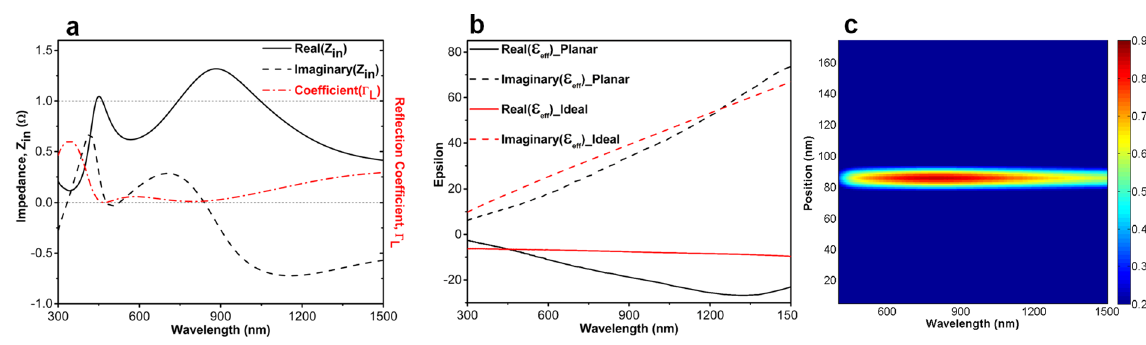
Figure 3. The extracted values for ( a ) input impedance and reflection coefficient of the MIMI structure, ( b ) real and imaginary part of permittivity for ideal and fabricated planar cases and ( c ) the absorption distribution over the MIM